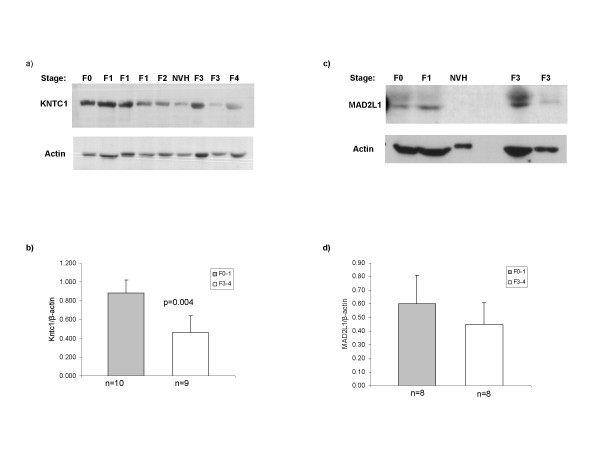
Reduced expression of mitotic checkpoint genes in chronic HCV patients. a & c) Western blotting for MAD2L1 and KNTC1 was done in total protein extracts prepared from biopsy specimens of chronic hepatitis C or Non-viral hepatitis patients (NVH). Following SDS-PAGE (12% gel) and transfer, the nitrocellulose membranes were probed with monoclonal antibodies to MAD2L1, which recognizes both phosphorylated and de-phosphorylated forms and KNTC1. b & d) Densitometry analysis of total MAD2L1 or KNTC1 expression normalized to their respective loading controls (β-actin) was done using Image J software. The number of samples analyzed in each group (n) is indicated below each column. The p-values at the top of the column compare early HCV to advanced HCV. Represented are mean ± S.D.